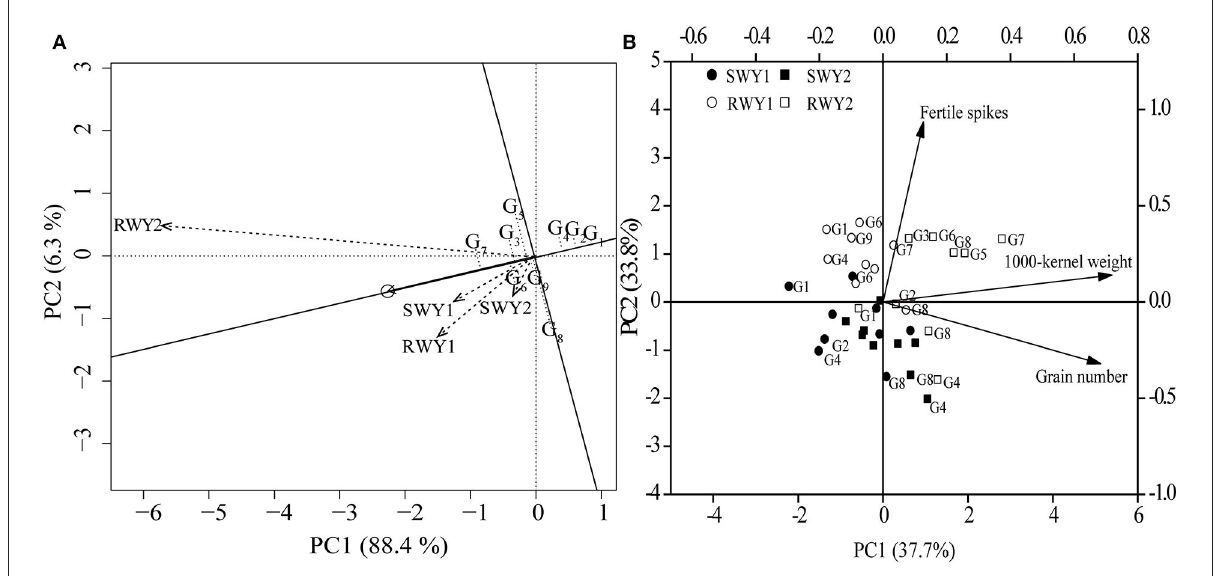
FIGURE3 The genotype main effects and genotype × environment interaction analysis (A) on mean yield, yield stability, and principal component analysis (PCA) (B) on yield components of nine wheat genotypes in two wheat cropping systems and two cropping years. All values were measured with three replications ( n = 3). The vectors represent the loading scores of variables for PC1 and PC2. SW, soybean-wheat cropping system; RW, rice-wheat cropping system; G, genotype; Y1, 2018–19 cropping year; Y2, 2019–20 cropping